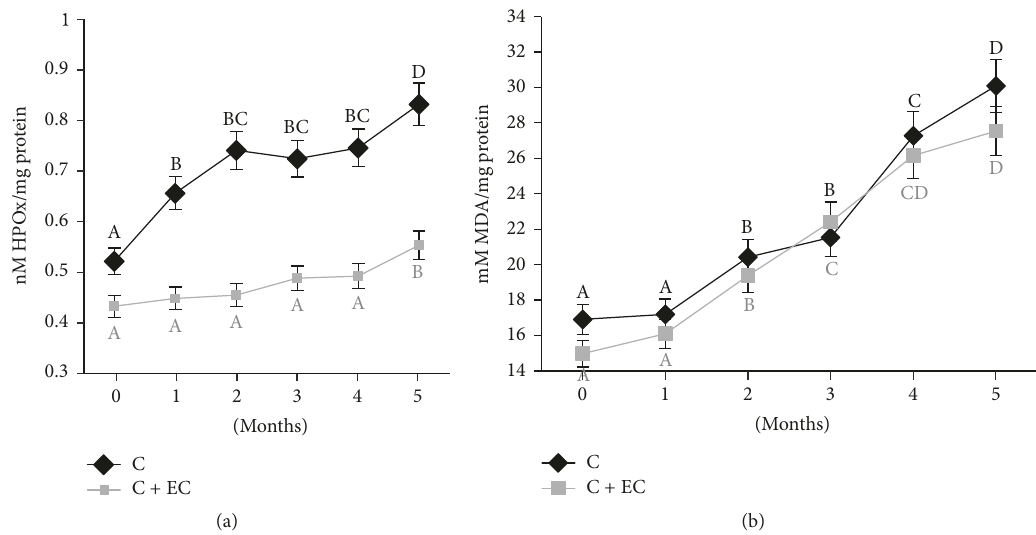
Figure 2: Changes in HPOx content (a) and MDA content (b) values of common carp fillets stored at − 18 ∘ C for 5 months. The results are the mean of three replications. C: fillet carp without coating; C + EC: fillet carp with edible coating. The different letters indicate significant differences between treatment times for the same treatment ( 𝑝 < 0.05 ).